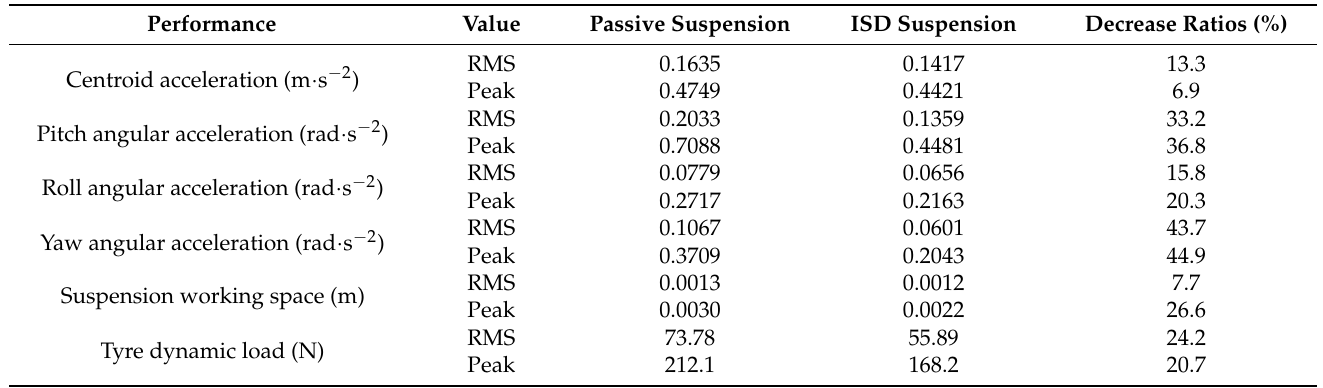
Table 3. Comparison of performance indicators under consecutive speed control humps.